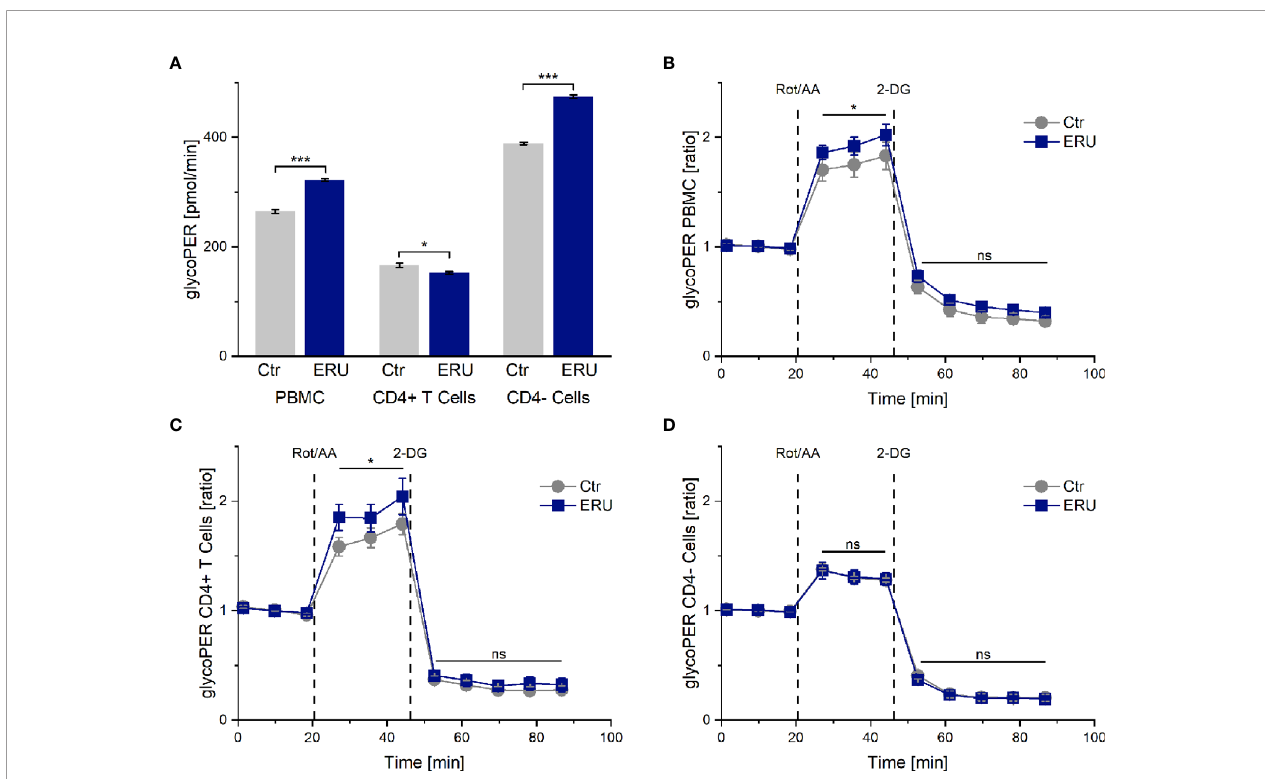
FIGURE 3 | Glycolytic proton ef fl ux (glycoPER) of PBMC, CD4 + T cells and CD4 - cells of healthy and ERU cases. Graph (A) shows the glycolytic proton ef fl ux rates of controls (grey, n=8) and ERU cases (blue, n=10), graphs (B – D) represent glycoPER ratios, normalized against the baseline mean. First three measurements (dots) show basal respiration, followed by injections of Rot/AA (after the third measurement point) and 2-DG (after the sixth measurement point). Data are shown as mean ± SEM. (A) Signi fi cantly increased basal glycolysis (***p ≤ 0.001) of PBMC and more precisely CD4 - cells of ERU cases, whereas CD4 + T cells of horses with ERU showed signi fi cantly lower basal glycolysis (*p ≤ 0.05). (B) Signi fi cantly higher glycoPER ratio (*p ≤ 0.05) of ERU PBMC after Rot/AA injection. (C) Signi fi cantly increased glycoPER (*p ≤ 0.05) of CD4 + T cells of ERU cases after Rot/AA injection. (D) CD4 - cells showed no difference in glycolysis ratios (ns p > 0.05) after treatment with Rot/ AA and 2-DG compared to